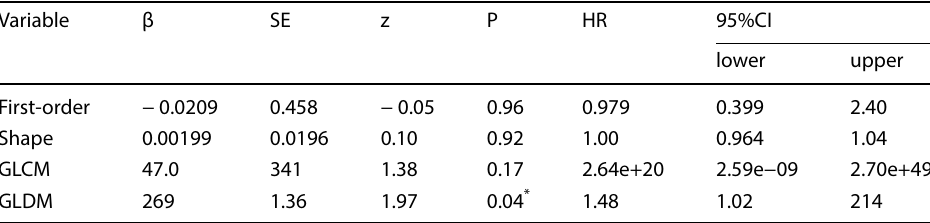
Table 2 Multivariable Cox regression analysis of four radiomic features of disease progression in the training